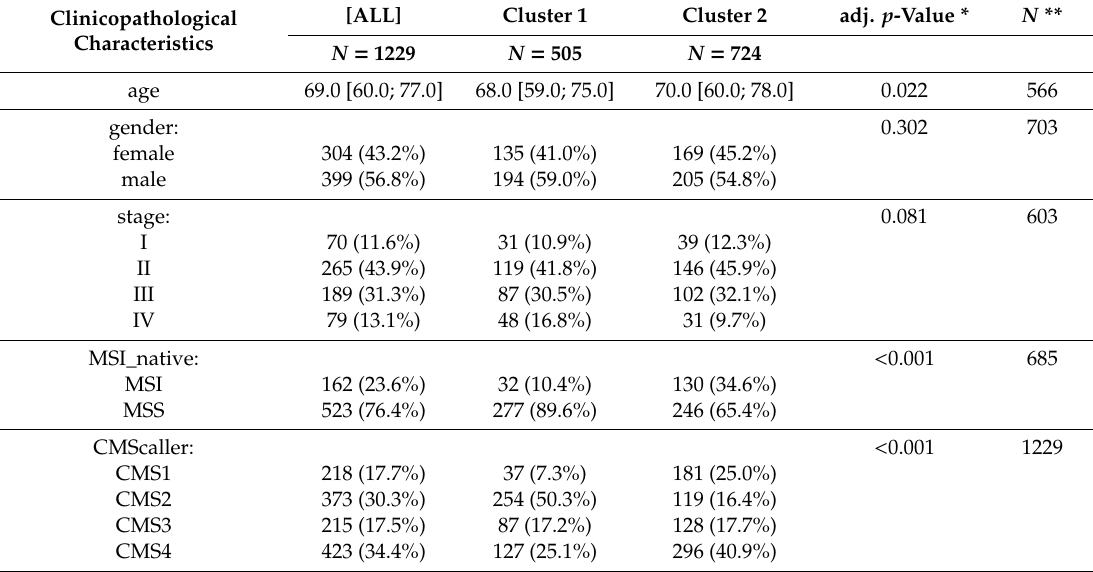
Table 2. Data of colorectal cancer patients (A ff ymetrix array